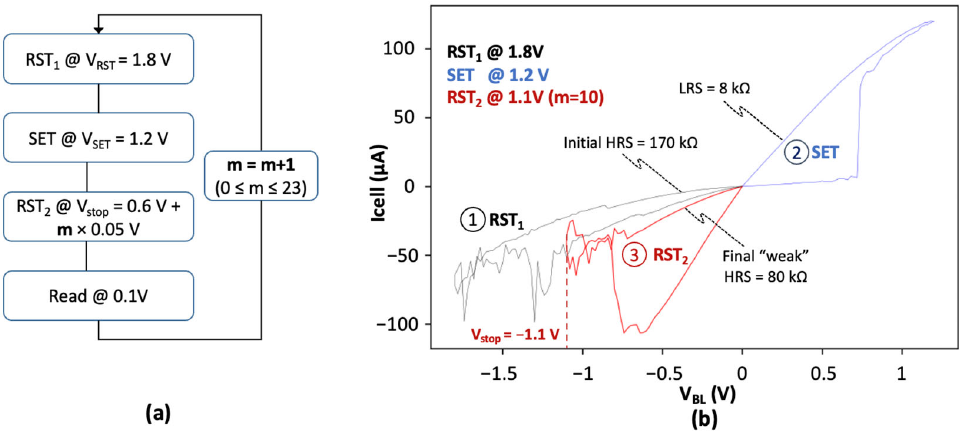
Figure 6. ( a ) R HRS conductance modulation measurement protocol and ( b ) resulting I–V curves. Results presented in Figure 6b are actually impacted by variability. C2C variability is clearly visible in Figure 7a where the programming sequence is repeated 10 times for an isolated cell (10 I–V hysteresis superimposed for V stop = 1.1 V). In Figure 7b, D2D variability is demonstrated by applying the programming sequence one time to each cell of the memory array (49 I–V hysteresis superimposed for V stop = 1.1 V). In Figure 7c, both C2C and D2D variabilities are captured after applying the programming sequence 10 times to the whole memory array.